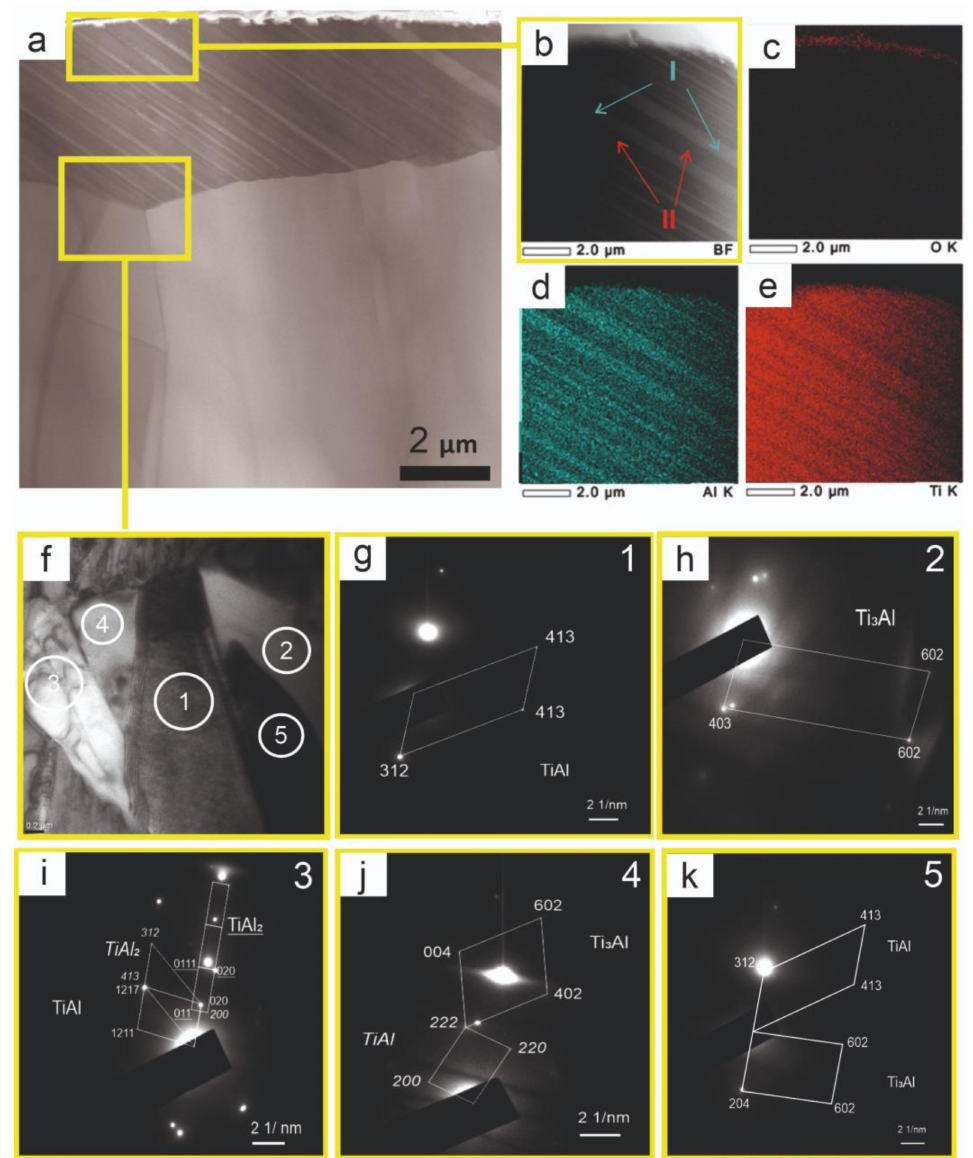
Figure 3. Tranmission electron microscopy (TEM) images of the Ti-Al alloy ( a , b , f ) with energy-dispersive spectral analysis of the alloys ( c , d , e ) and the Selected Area Electron Diffraction analysis (SAED) patterns with identification of relevant areas ((1)— g , (2)— h , (3)— i , (4)— j , (5)— k